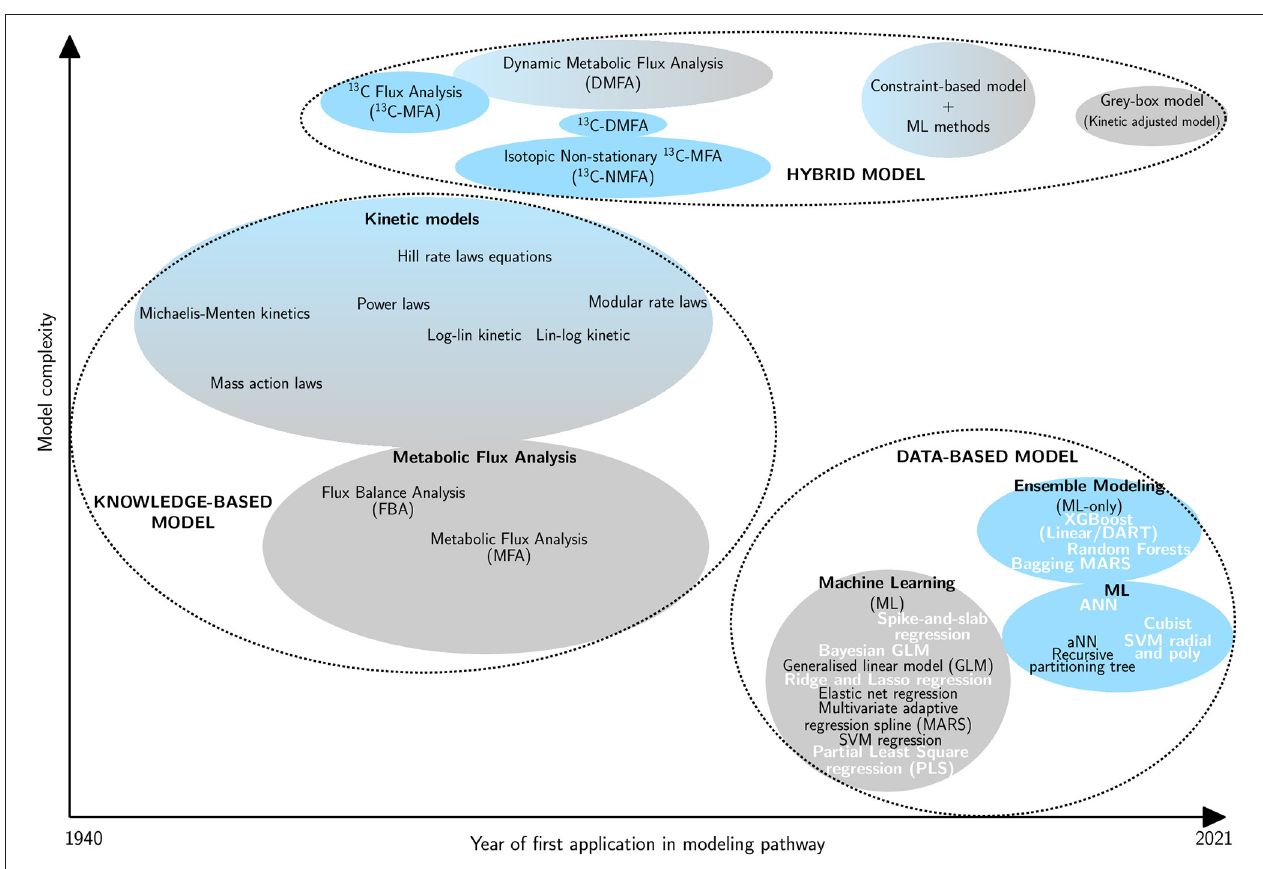
FIGURE 1 | Classification of metabolic pathway modeling methods according to their complexity and the year of first application in this field. The ellipse size is proportional to the occurrence of the method for pathway modeling in the literature. Three main groups are defined: knowledge-based model (Michaelis and Menten, 1913; Chance, 1943; Shapiro and Shapley, 1965; Garfinkel et al., 1970; Savageau, 1970, 1988; Fell and Small, 1986; Hatzimanikatis and Bailey, 1997; Curto et al., 1998; Heijnen, 2005; Liebermeister et al., 2010), data-based model (Wu et al., 2016; Cuperlovic-Culf, 2018; Ajjolli Nagaraja et al., 2019; Zampieri et al., 2019; Zhang et al., 2019; Kim et al., 2020 ) and hybrid model (Wiechert et al., 1997; Drysch et al., 2003; Antoniewicz et al., 2007; Nöh et al., 2007; Leighty and Antoniewicz, 2011; Antoniewicz, 2015; Pan et al., 2017; Yousoff et al., 2017; Heckmann, 2018; Oyetunde et al., 2019; Zampieri et al., 2019; Lo-Thong et al., 2020; Rana et al., 2020 ). Linear methods are represented in gray and non-linear ones are in blue. Methods in bold and white are those evaluated in this study.